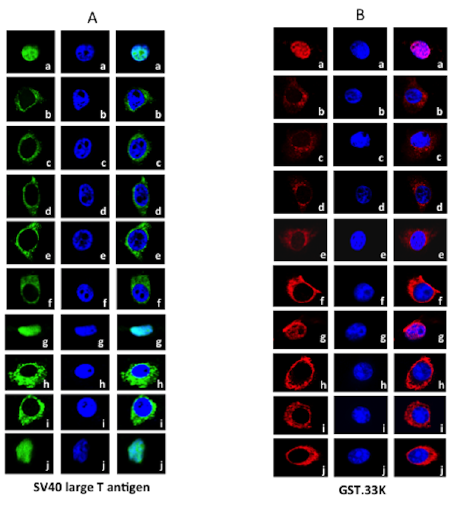
Figure 3. Sub cellular localization of mutant 33Ksr protein. ( A ) Amino acid homology of BAdV-3 33K like proteins . Alignment of deduced amino acid sequences of BAdV-3 33K homologs with those of canine adenovirus (CAdV)-2 (GeneBank Accession # AC_000020), HAdV-2 (GeneBank Accession # AC_000007), HAdV-5 (GeneBank Accession # AC_000008), HAdV-35 (GeneBank Accession # AC_000019). The potential RS domain is overlined. RS repeat residues are indicated (*). ( B ) Schematic representation of BAdV-3 33K fusion proteins . The number above the thick box denote the amino acid number for 33K protein. Thick box represent BAdV-3 DNA. Dotted lines represent deleted regions. The name of the individual mutant protein is indicated to the left of the panel. The name of the individual plasmid is indicated on the right of the panel. ( C ) Western blot . Proteins from lysates of 293T cells transfected with indicated plasmids were separated by 15% SDS-PAGE, transferred to nitrocellulose and probed in Western Blot using anti-33K serum [15]. ( D ) Immunofluorescence . Monolayers of HeLa cells were transfected with indicated individual plasmid DNA and analysed at 48 hrs post transfection by indirect immunofluorescence by staining with anti-33Kp serum [15], Cy 3 conjugated goat anti-rabbit serum and DAPI and analyzed by direct fluorescence. The name of the plasmid is indicated on the left of the panel. doi:10.1371/journal.pone.0101216.g003 (lane 4) or importin- b 1 (lane 3) bound to glutathione sepharose beads were used in pull down assays.